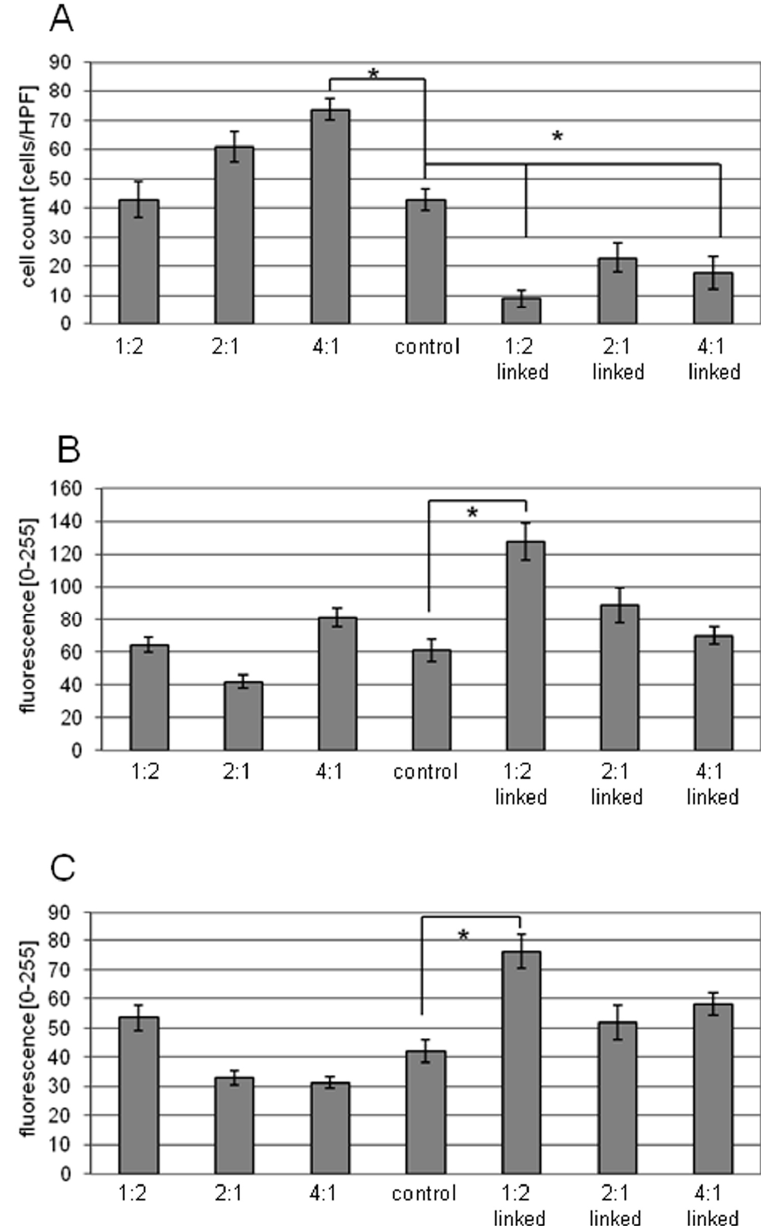
FIGURE 3. Influence of PLLA-COLI ratio on growth and differentiation of hMSC. Cell count (A), COLI deposition (B), and OC deposition (C) as determined by fluorescence analysis after 22 days of culture under growth